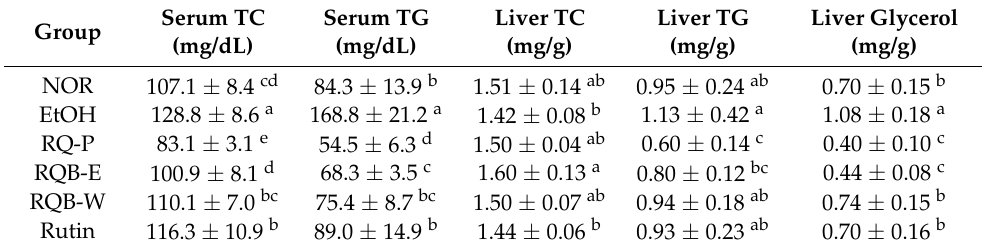
Table 4. Serum and liver lipid contents of the AFLD